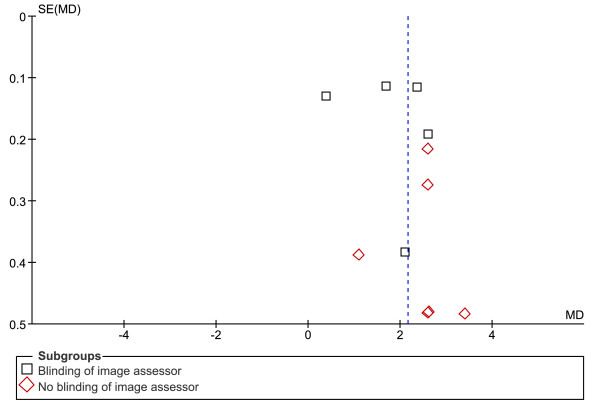
Funnel plot of studies reporting the thickness of the proximal plantar fascia by ultrasonography. Sub-group analysis: blinding versus no blinding of image assessor.